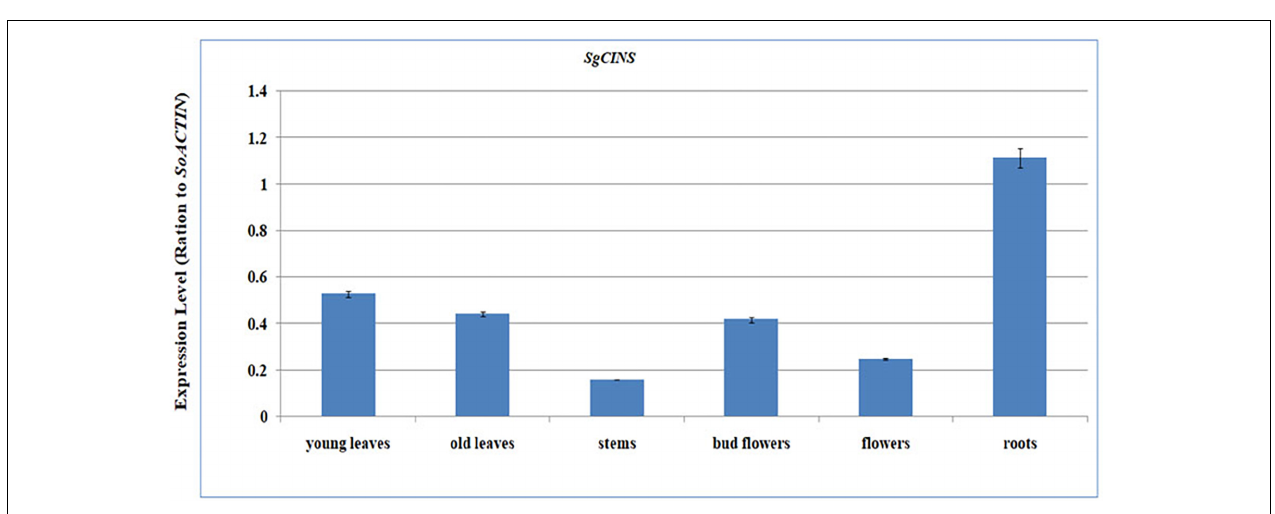
FIGURE 3 | Quantitative RT-PCR validation of expression of SgCINS gene in S. guaranitica . Total RNAs were extracted from young leaves, old leaves, stem, bud flower, flower, and root samples, and the expression of gCINS gene was analyzed using quantitative RT-PCR. SgACTIN was used as the internal reference. The values are means ± SE of three biological